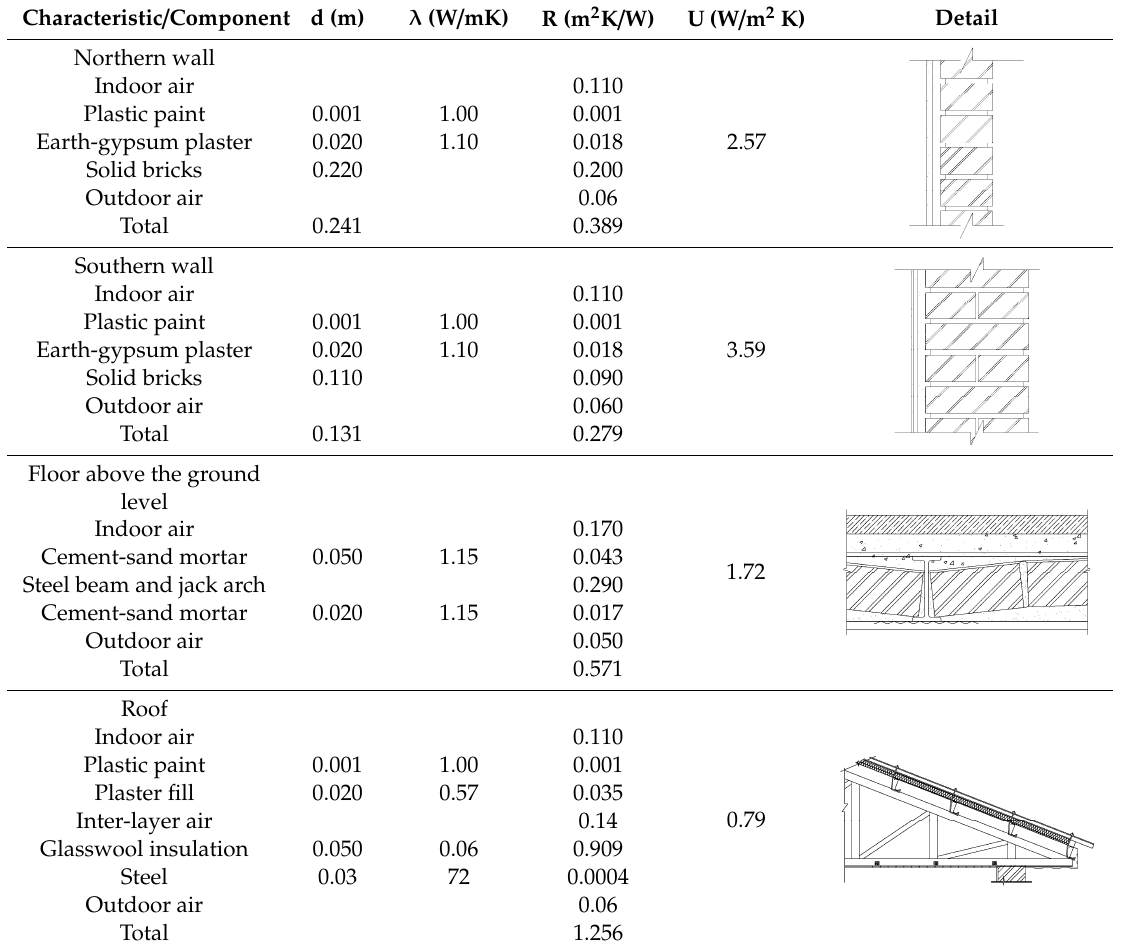
Table 3. Specifications of the building elements.